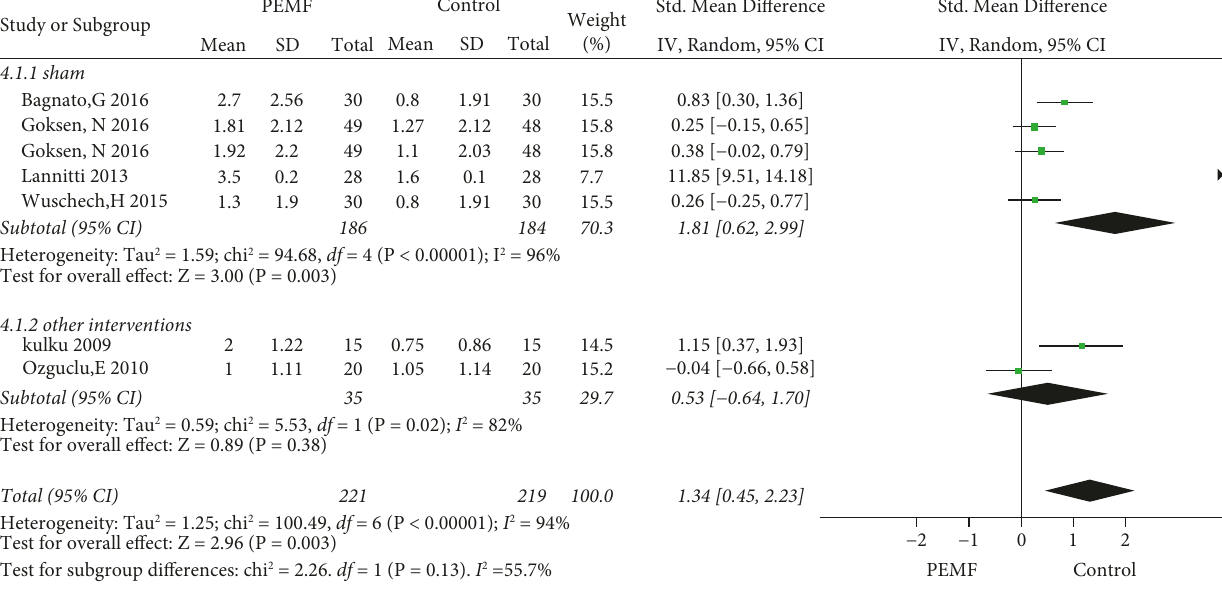
Figure 8: Forest plots represent the effect of PEMF versus control therapies in stiffness and subgroup analysis basing on different type of control